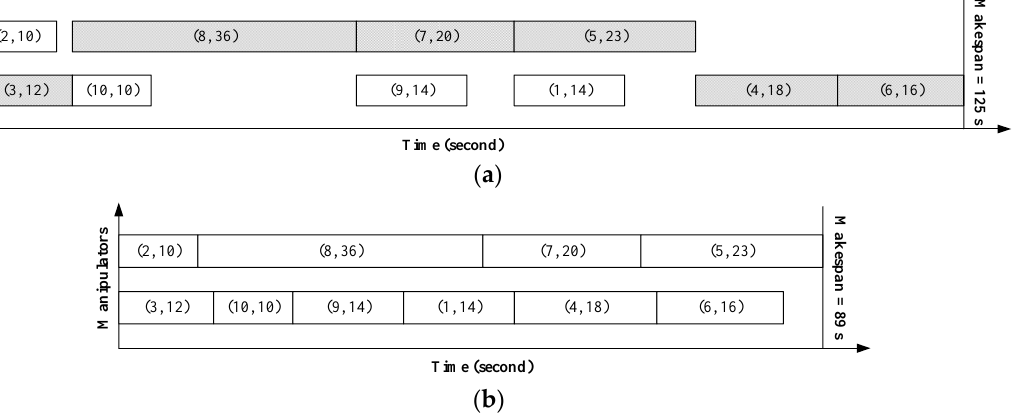
Figure 2. The comparison between two parallel disassembly processes. ( a ) Synchronous parallel disassembly process. ( b ) Asynchronous parallel disassembly process.